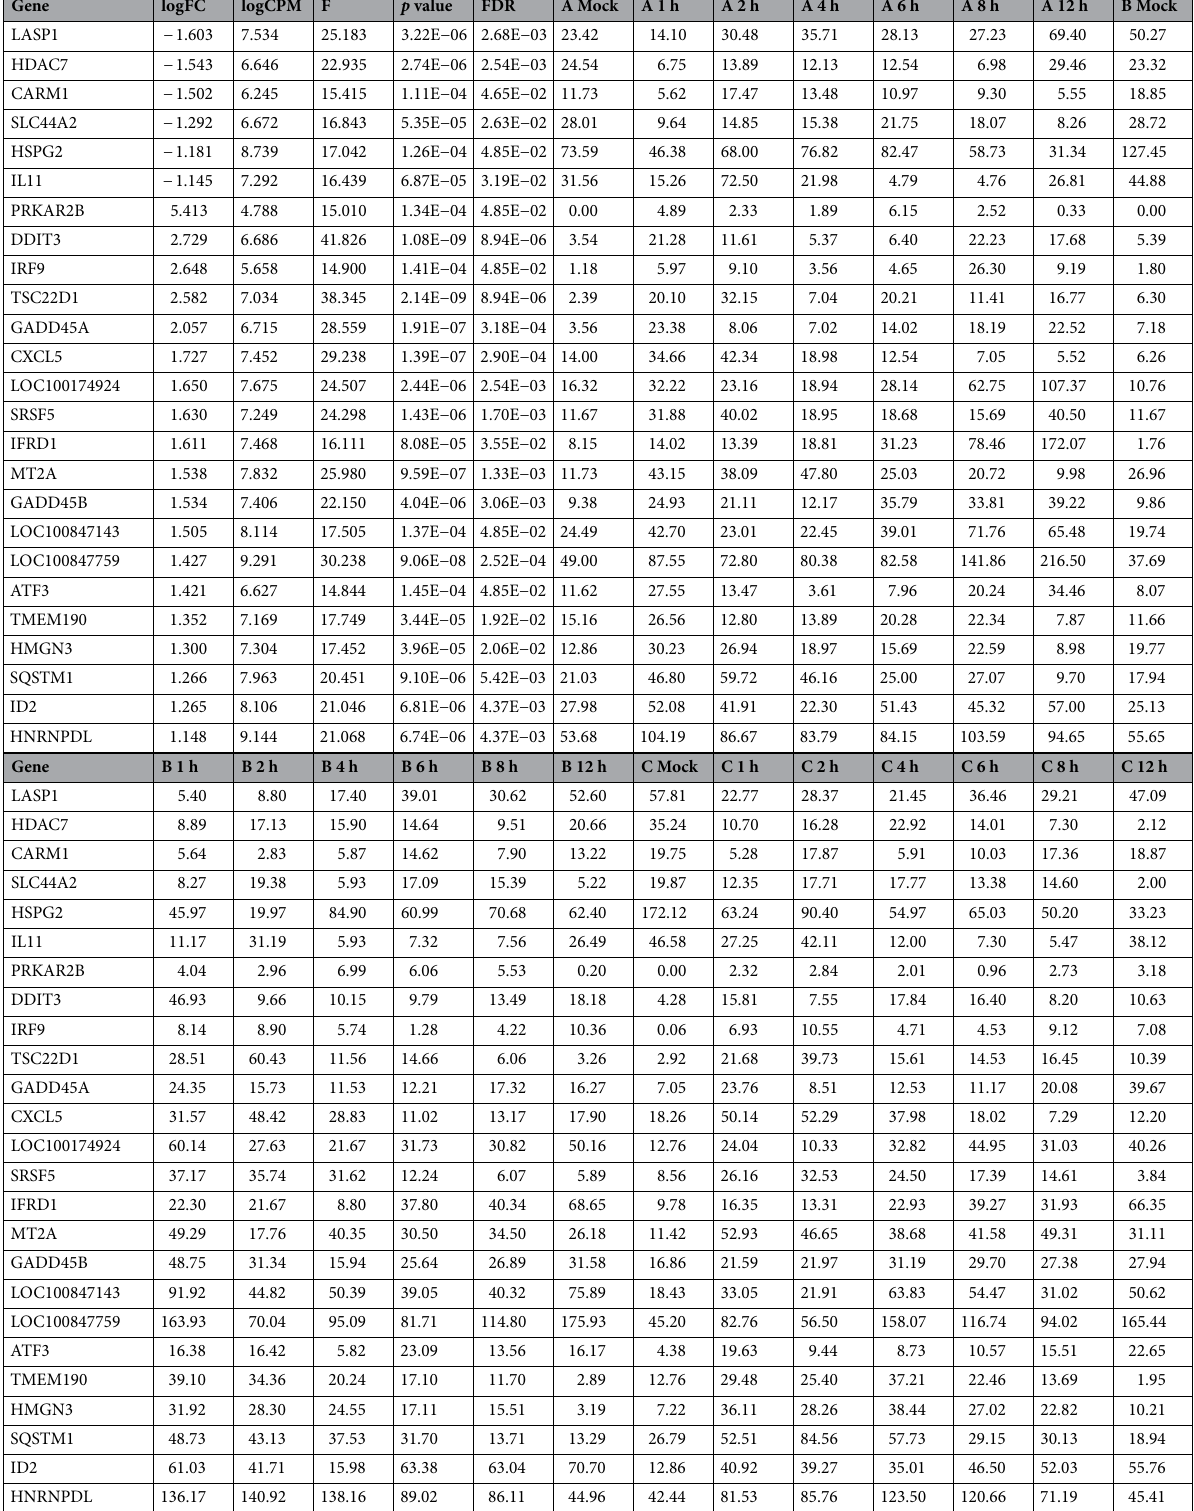
Table 1. Up- and downregulated bovine genes in response of viral infection. We detected significant upregulation in 19 and 6 downregulation in 6 host genes in all of the three biological